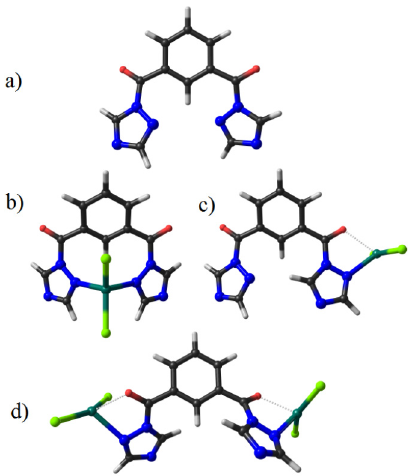
Figure 2. Representative structures for both ligand and metallic complexes. ( a ) Free ligand ( 1 ); ( b ) The metal is coordinated only via N,N of the triazolyl ligand; ( c ) The metal is coordinated via a C=O and a N from the triazolyl ligand moiety; ( d ) Two metals are coordinated via the C=O and N moieties of the triazolyl ligand. Calculations were done by using DFT TZ2P/BP86-D3 level of theory. Because we observed shifts in the C=O band to lower wavenumbers (relative to the free ligand)